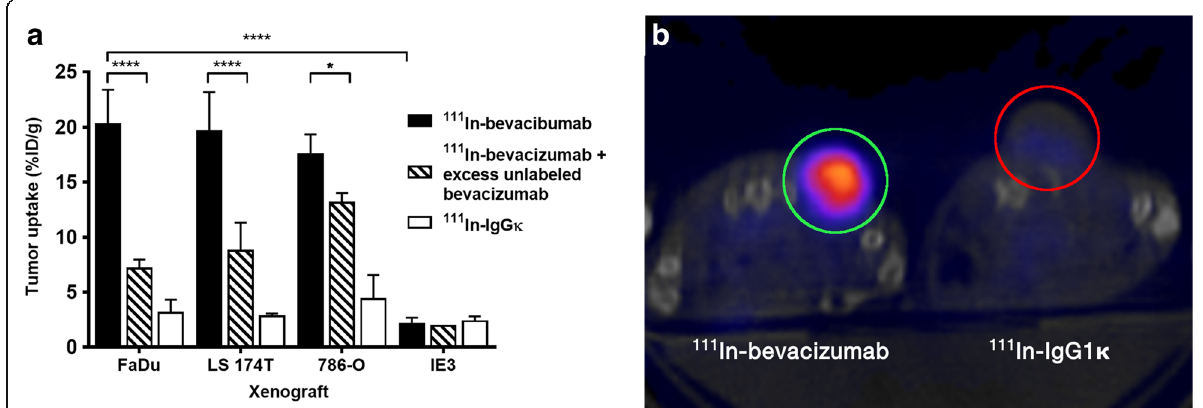
Fig. 3 a Specificity of uptake of 111 In-bevacizumab. Uptake of 111 In-bevacizumab ( black ); 111 In-bevacizumab + excess of unlabelled bevacizumab ( hatched ) and 111 In-IgG1 κ ( white ) in different tumour models. Data are presented as mean±SEM, * P <0.05; **** P <0.0001, n =minimum of 4 mice/